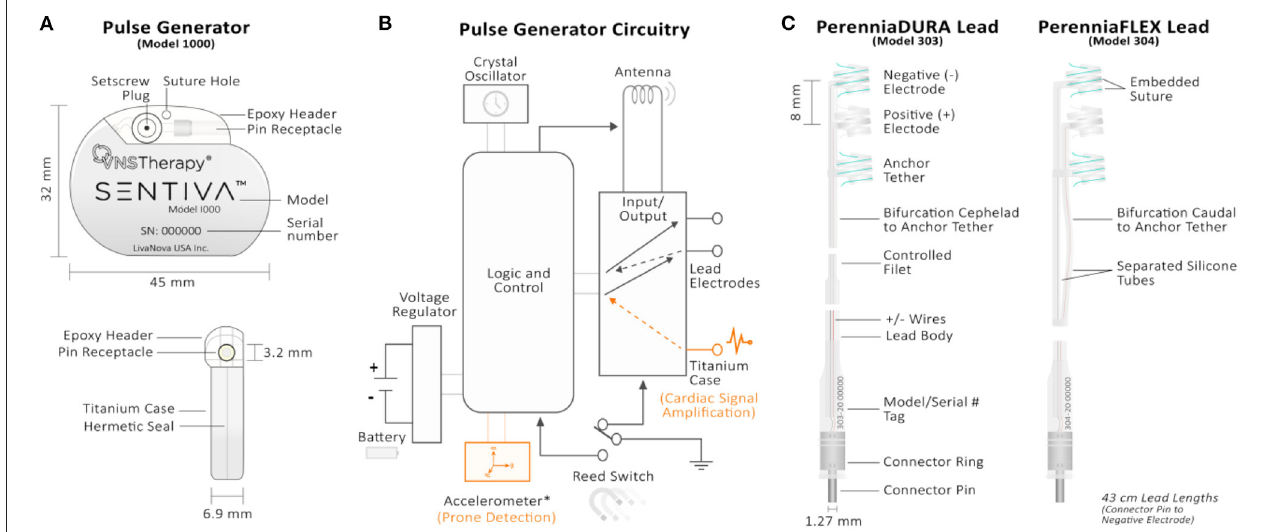
FIGURE 2 | Technical overview of the VNS Therapy System’s implantable components. (A) Front (top) and side (bottom) views of the M1000 implantable pulse generator. The generator circuitry is hermetically sealed in a titanium case. A hex screwdriver is inserted into the setscrew plug receptacle during surgery to secure the lead’s connector pin upon insertion. Model and serial number information are printed on the front face of each generator. (B) Pulse generator circuitry schematic. The generator’s circuitry includes, (1) crystal oscillator to provide a timing reference; (2) voltage regulator to regulate the system power supply from the battery; (3) antenna to receive programming signals and transmmit telemetry information to the Programming Wand; (4) logic and control that receives and implements programming commands, as well as collects and stores telemetry information (i.e., memory); (5) input/output controller to develop and modulate signals delivered to the lead. It can also allow the traditional VNS to serve as both therapy outputs and sensing inputs; (6) reed switch controlled by swiping the therapy’s patient magent. For the M106, M1000, and M1000-D generators, the logic and control also processes sensory information (heart rate) and controls sensory-based therapy outputs (AutoStim). Components unique to the therapy’s closed-loop generators (models 106, 1000, and 1000-D) are shown in orange. The input controller of closed-loop generators through the titanium case connection provides cardiac signal amplification. The accelerometer is unique to M1000 and M1000-D generators and provides information related to patient posture for prone event detection. (C) Single-pin PerenniaDURA M303 (left) and PerenniaFLEX M304 (right) implantable leads. Each lead features two active helical electrodes (negative and positive) that provides therapy output and a non-active anchor tether electrode used for stabalization purposes. Embedded sutures in the silicone casing of the helical eletrodes allows manipulation with forceps during surgery. The increased flexibility of the M304 lead is provided by the separated silicone tube configuration